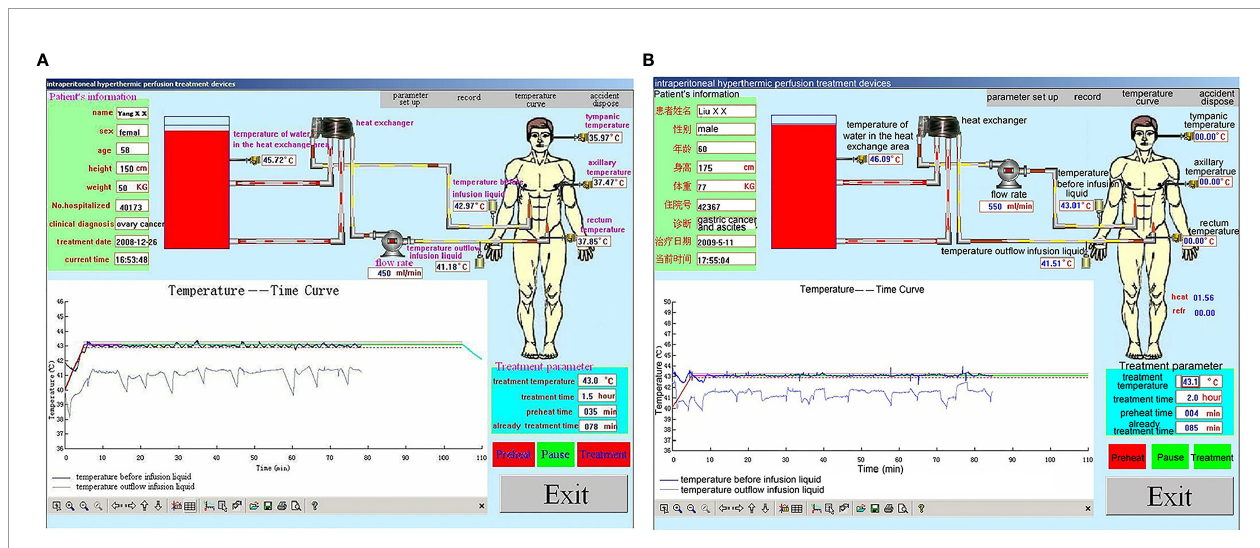
FIGURE 5 | Representative performance graphs of the temperature control of the BR-TRG-I-type intraperitoneal hyperthermic perfusion chemotherapy (HIPEC) device in two patients at the fi rst HIPEC session. (A) HIPEC followed by dCRS. (B) HIPEC followed by minimally invasive surgery. The graphs show that the temperature in the infusion and out fl ow catheters was stable at 43°C and 41.8°C. The performance was similar between the two approaches.